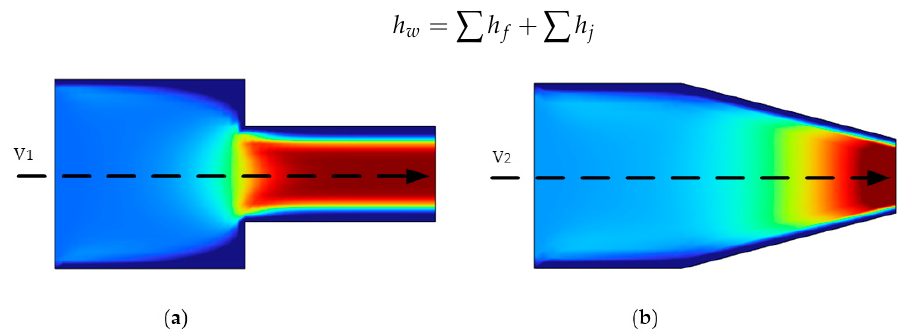
Figure 2. Analyzing the fluid flow in different pipes. ( a ) Analyzing the fluid flow in an abruptly reduced tube; ( b ) Analyzing the fluid flow in a gradually reduced tube.